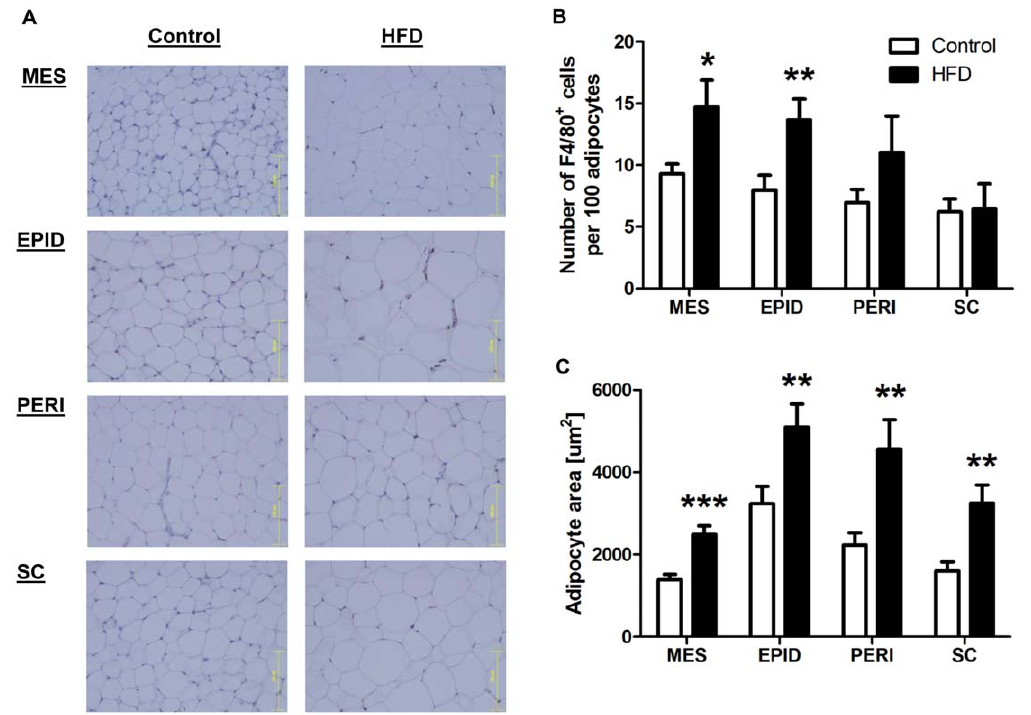
Figure 6. Effect of high saturated fat diet (HFD) on adipose macrophage infiltration and adipocyte size. A: Representative immunohistochemical staining of mesenteric (MES), epididymal (EPID), perirenal (PERI) and subcutaneous (SC) fat. Quantification of macrophage (F4/ 80 + ) infiltration (B) and adipocyte size (C). Tissues were fixed in formalin and embedded in paraffin. Sections were stained for F4/80 and counterstained with hematoxylin. Open bars=control; Closed bars=HFD (n=4–10 per group). Data are shown as mean 6 SEM. *** P , 0.001, ** P , 0.01 and * P , 0.05 compared to control.